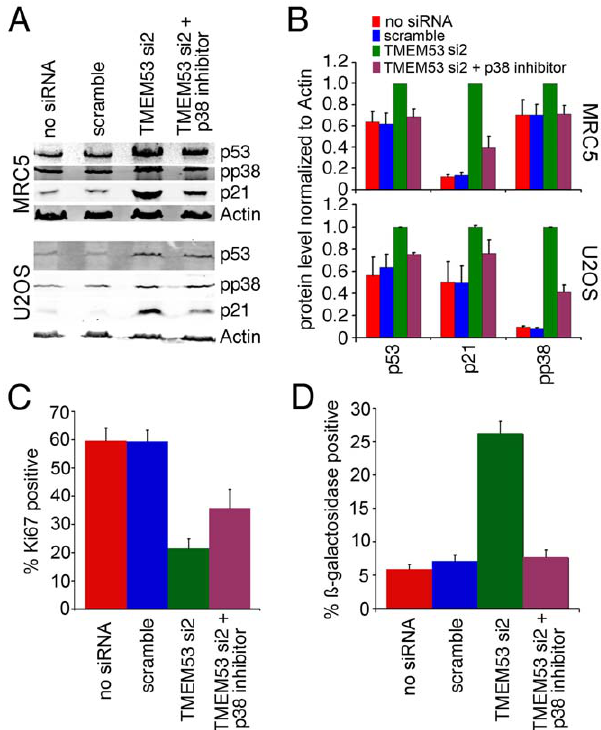
Figure 10. p38MAP kinase mediates the NET4/Tmem53 effects on cell cycle proteins. MRC5 and U2OS cells transfected with either siRNA oligos or controls were treated 24 h after transfection with a specific inhibitor of the p38MAP kinase. (A) Protein lysates were generated after a further 48 h and analyzed by Western blot for levels of p53, phosphorylated p38, and p21. This experiment was repeated 3 times and a representative Western blot is shown. (B) Levels of p53, p21 and phosphorylated p38 were quantified from three separate experiments analyzed by LI-COR using fluorescent secondary antibodies and are plotted normalized to the actin control with standard errors. In all cases the p38MAP kinase inhibitor blocked the effects of NET4/ TMEM53 knockdown on levels of these cell cycle proteins. (C) The change in the percentage of Ki-67 positive cells induced by NET4/ TMEM53 knockdown is partially abrogated by blocking the function of p38 kinase. (D) Effects of NET4/TMEM53 knockdown on senescence, as determined by ß-galactosidase staining, are abrogated by blocking p38MAP kinase function.